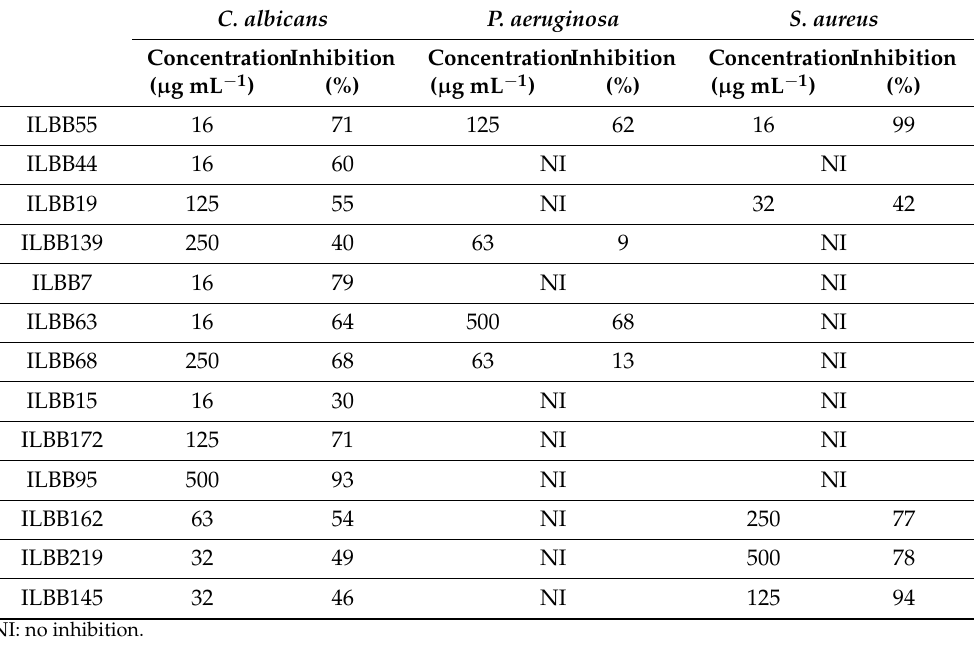
Table 3. Inhibition of extracts on biofilm formation.